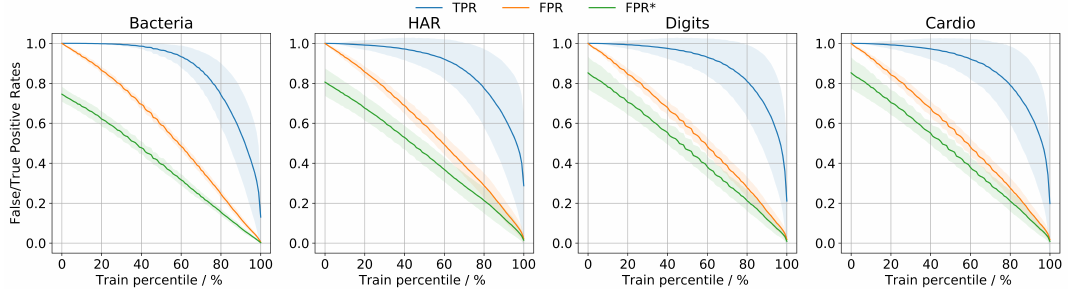
Figure 3. Relation between TPR, FPR, FPR* and train percentiles. FPR* stands for an adjust FPR, where misclassified inputs were removed from the